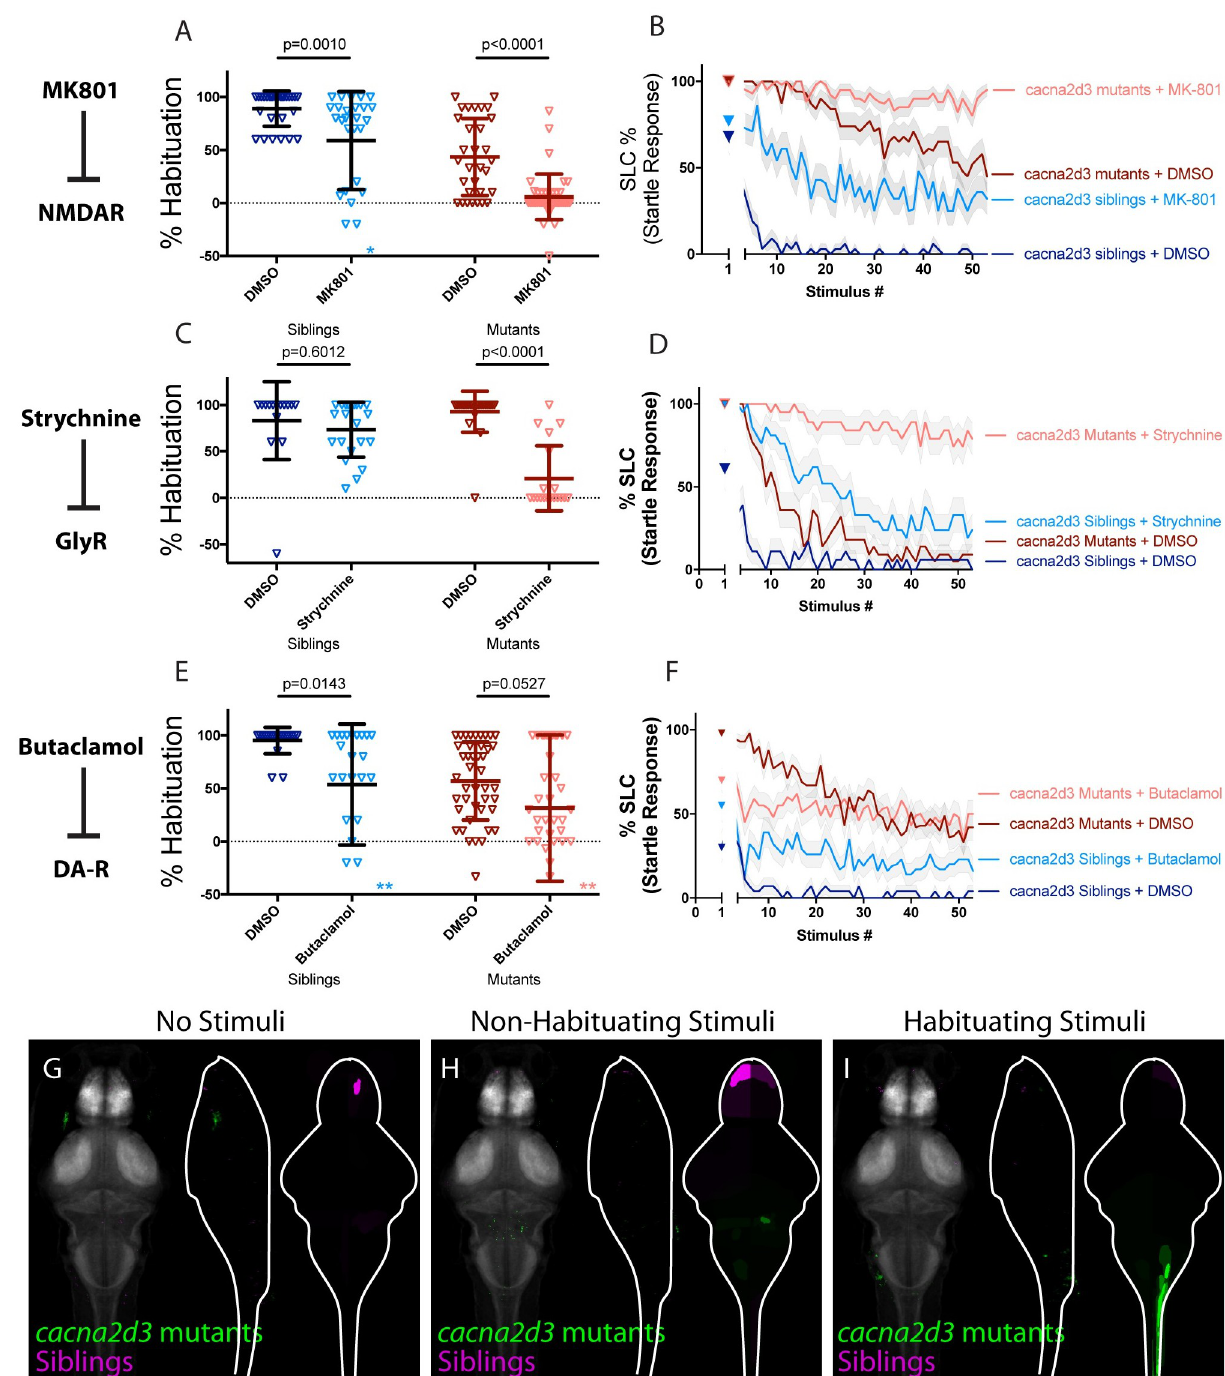
Fig 5. CACNA2D3 acts independently of other regulators of habituation learning. (A-B) MK-801 significantly enhances habituation learning deficits observed in cacna2d3 mutant larvae, indicating that NMDA signaling and cacna2d3 may act within parallel molecular or circuit pathways to regulate habituation learning (p = 0.0010, n = 28 DMSO siblings, n = 27 MK-801 siblings, vs. p < 0.0001, n = 31 DMSO mutants, n = 41 MK-801 mutants; p = 0.5130 indicates non-significant interaction between drug treatment and genotype). * indicates a sibling+MK801 individual with a % hab value below y-axis limit at -60% (C-D) Strychnine significantly enhances habituation learning deficits observed in cacna2d3 mutant larvae, indicating that glycine signaling and cacna2d3 may act within parallel molecular or circuit pathways to regulate habituation (p = 0.6012, n = 15 DMSO siblings, n = 21 Strychnine siblings vs. p < 0.0001, n = 22 DMSO mutants, n = 19 Strychnine mutants; p < 0.0001 indicates significant interaction between drug treatment and genotype owing to minimal reaction of cacna2d3 siblings to Strychnine treatment). (E-F) Butaclamol does not significantly enhance habituation